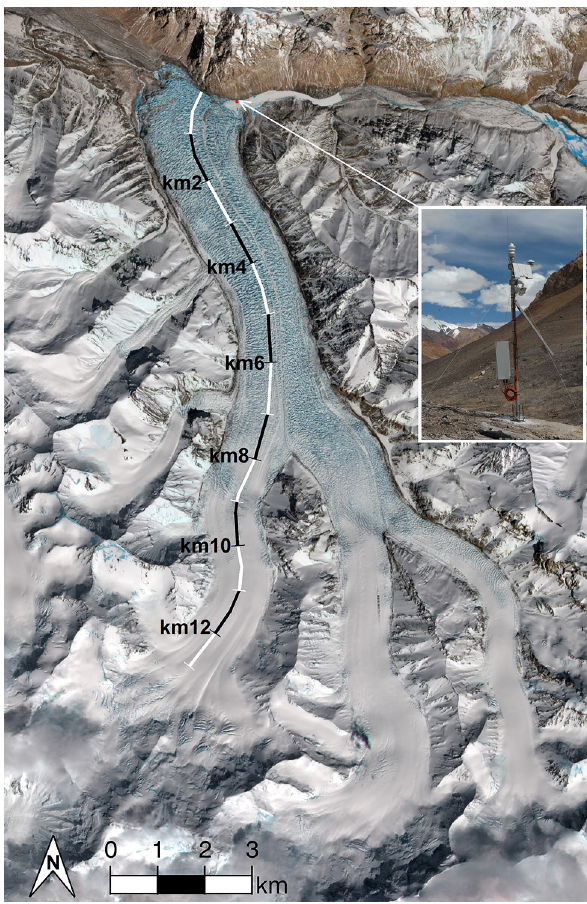
Figure 3. Optical image of Kyagar Glacier on 29 March 2016 from the ESA Sentinel-2A satellite. The glacier-dammed lake of approx- imately 5millionm 3 is visible to the east of the glacier terminus. The curved scale bar up the west branch indicates the longitudinal profile used for surface velocity and elevation analysis, and the inset shows the monitoring station located about 500m upstream of the glacier terminus.